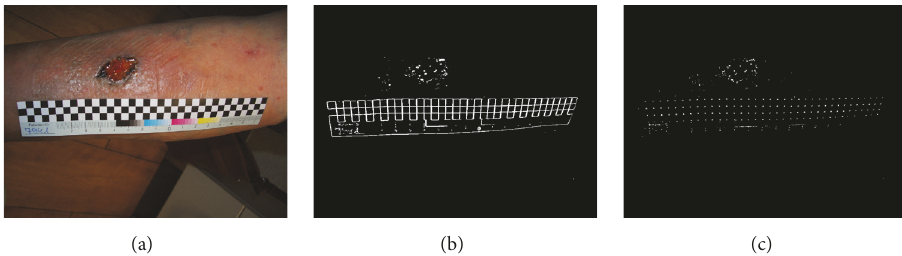
Figure 2: (a) Original wound image and the ruler. (b) Result of structure tensor filter for one high eigenvalue. (c) The result of structure tensor filter for two high